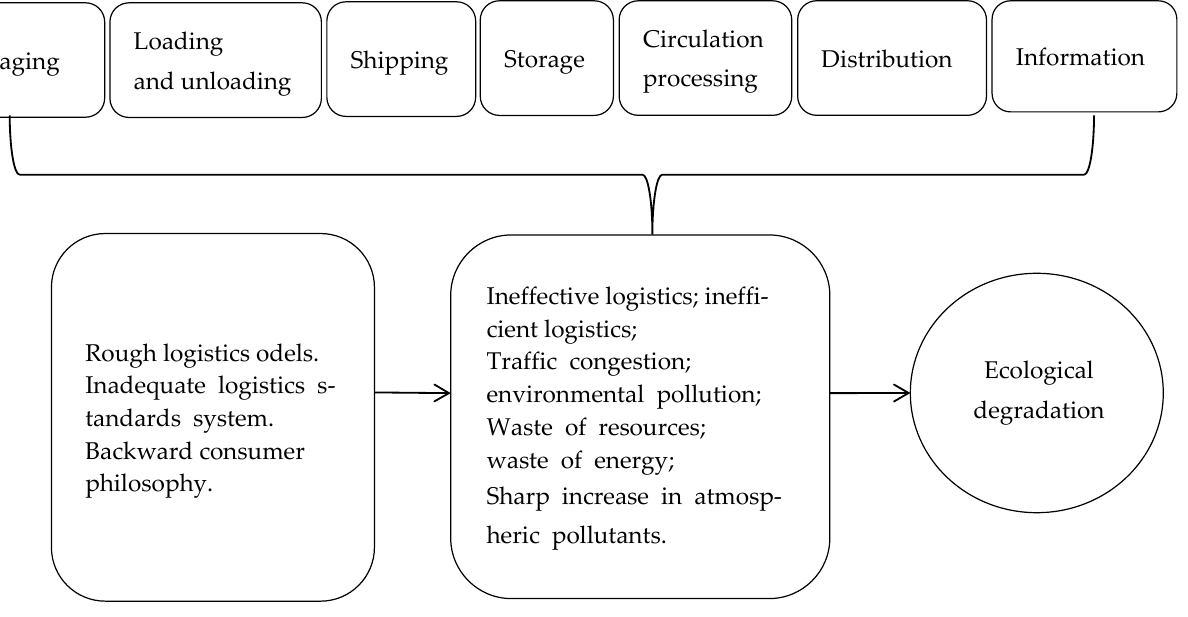
Figure 1. Mechanisms of action by which logistics activities exert an impact on the ecological environment.